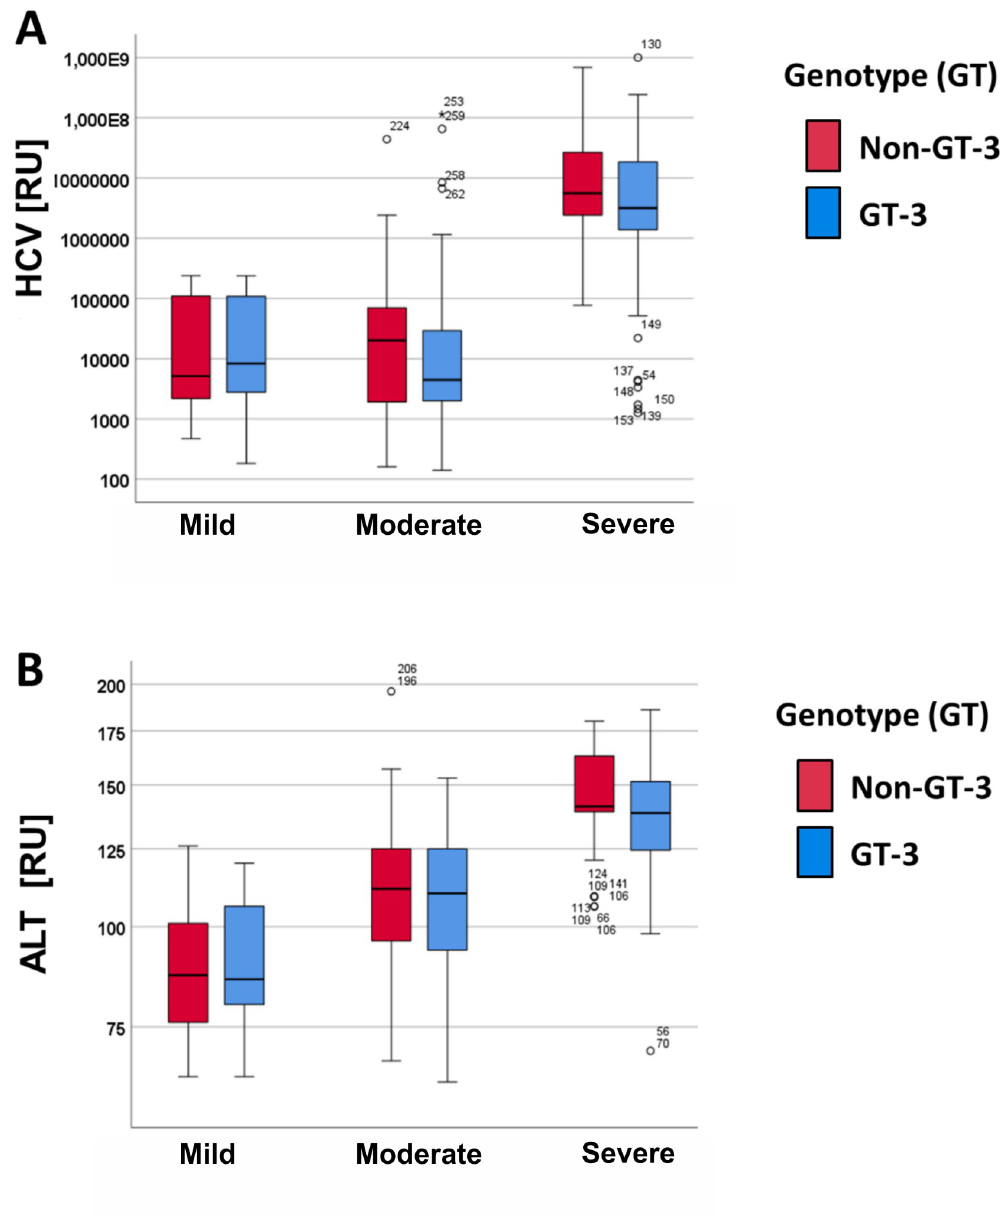
Fig 3. Comparison of non-genotype 3 vs. genotype 3 in patients with mild, moderate and severe cirrhosis. A: HCV, B: ALT.